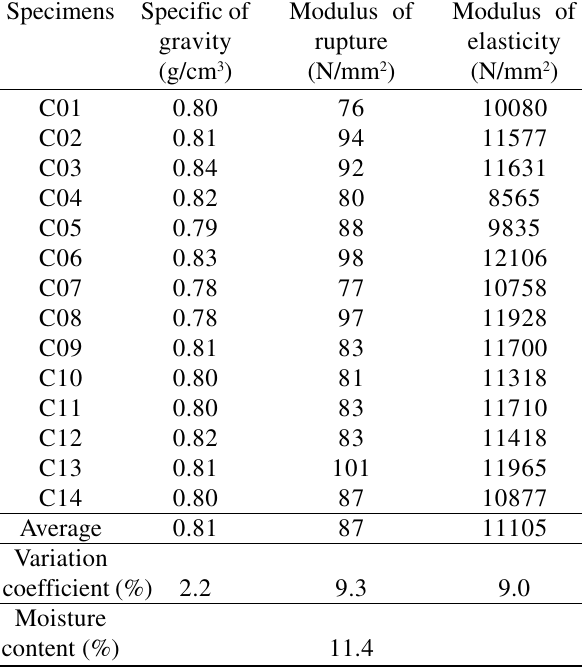
Table 2. Results in the tests for direction parallel to the grain of the external